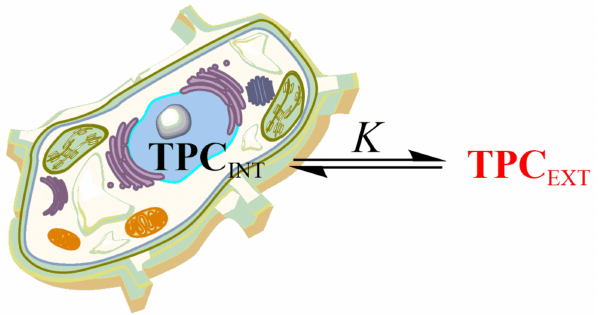
Figure 2. Variation of the intracellular ( a ) and extracellular ( b ) phenolic content (or production) expressed in terms of total gallic acid equivalents (GAE, mg / L) in non-elicited (control) and cyclodextrin (CD)-treated B. × houghtonii suspension cultured cells BHSCC extracts ([CD] = 50 mM) over time. Values are given as the mean ± SD of triplicates and (*) refers to significant di ff erences between control and treatments for each day ( p <